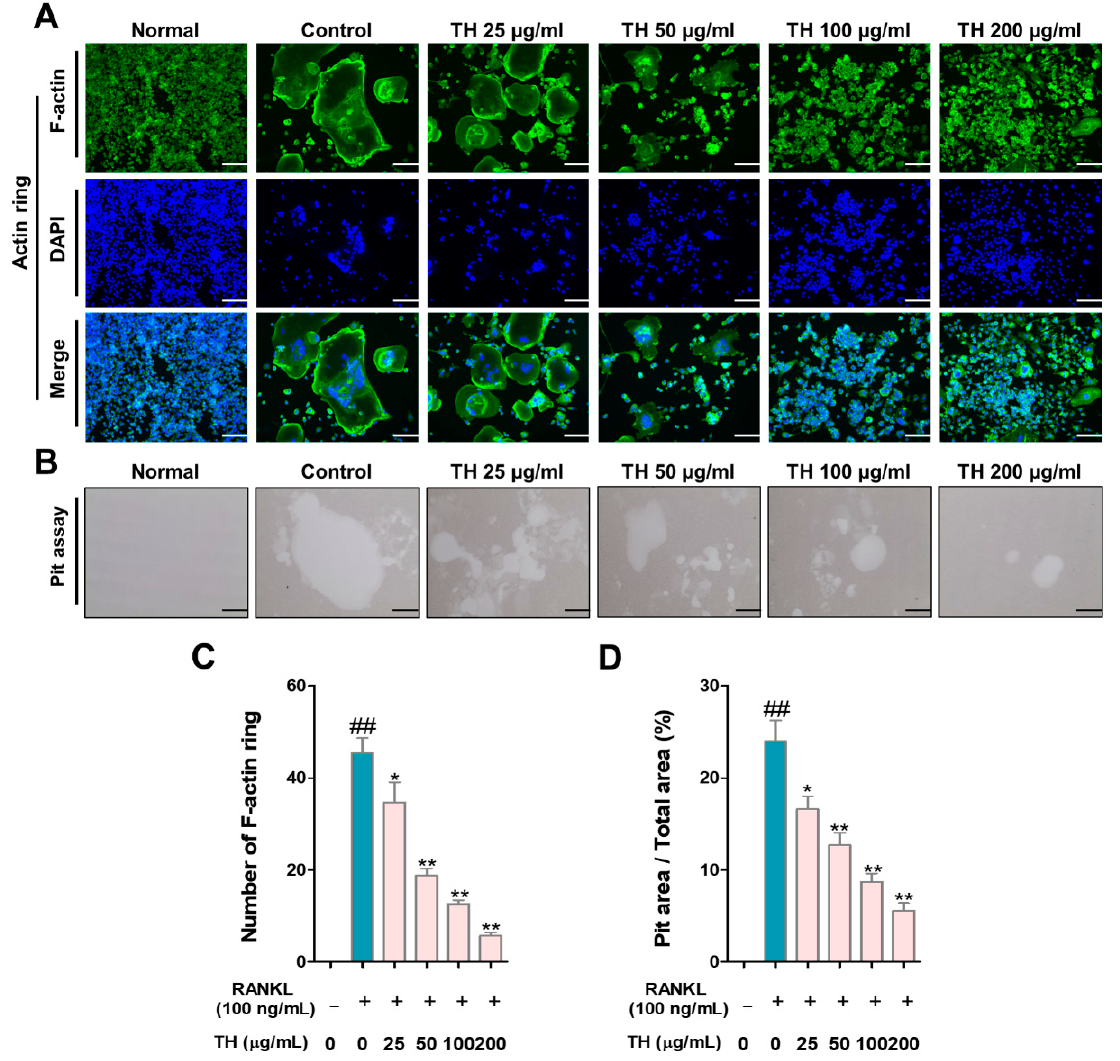
Figure 3. Taraxaci Herba (TH) treatment reduced F-actin ring formation, size, and pit area. ( A ) Rep- resentative images of F-actin ring ( × 100; scale bar, 200 µ m). ( B ) Representative images of pit area of nuclear factor- κ B (NF- κ B) ligand (RANKL)-induced osteoclast differentiation in RAW 264.7 cells ( × 100; scale bar, 200 µ m). ( C , D ) Measurement of F-actin ring-positive cells and pit area using ImageJ software Ver. 1.46. The experiments’ representative images are shown, and the graphs are expressed as the mean ± standard error of the mean (SEM; n = 3). ## p < 0.01 vs. normal group; * p < 0.05, ** p < 0.01 vs. control group.